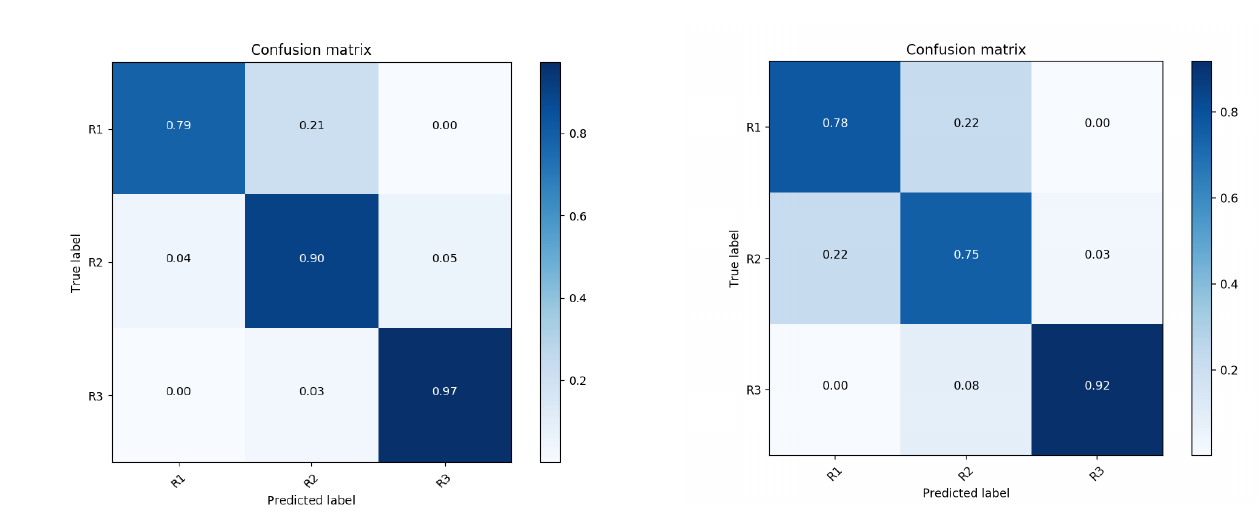
Figure 8. Confusion Matrix for the Random Forest algorithm trained on the training data, with optimized parameters for both imputation and smoothing opera- tions, and validated with the test data.